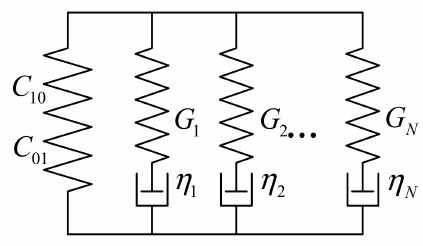
Figure 3. Hyperelasticity-viscoelasticity